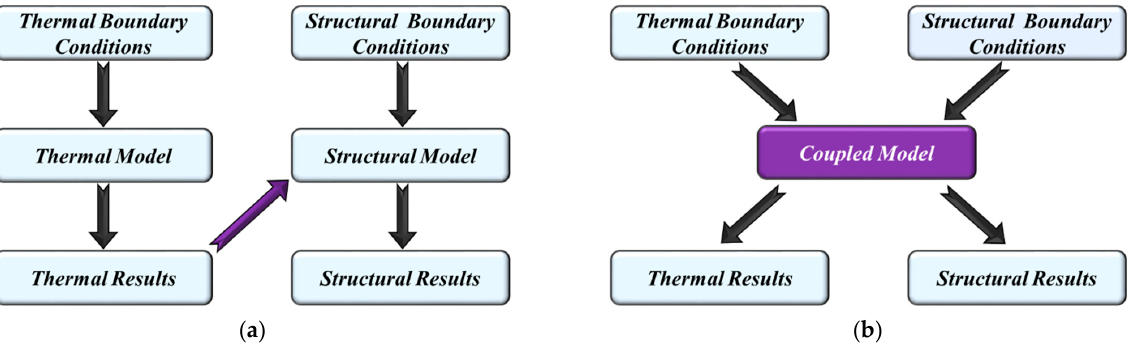
Figure 2. ( a ) Sequential and ( b ) Direct Coupling